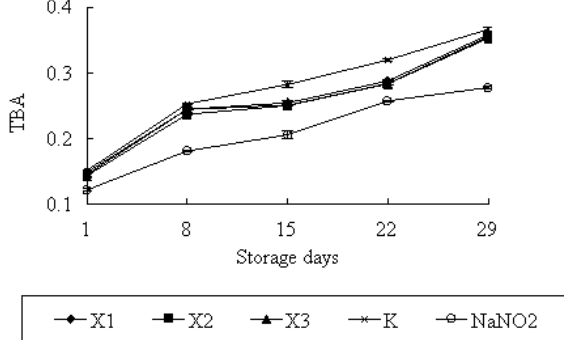
Figure 3. The changes in VBN of pork sausages. VBN: mg malonaldehyde/kg sample. X1, X2 and X3 stand for the samples with 0.1%, 0.2% and 0.3% Amaranthus pigments addition, respectively; K stands for the controls, NaNO 2 stands for the samples with 0.015% NaNO 2